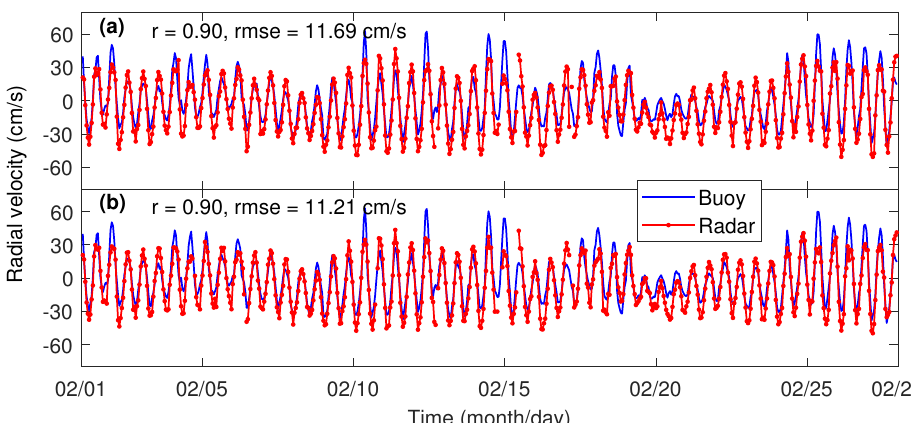
Figure 13. As in Figure 12, but for SHLI at buoy A. ( a ) the value of the constant number is equal to 0.2 ( µ = 0.2); ( b ) the value of the constant number is equal to 20 ( µ = 20).